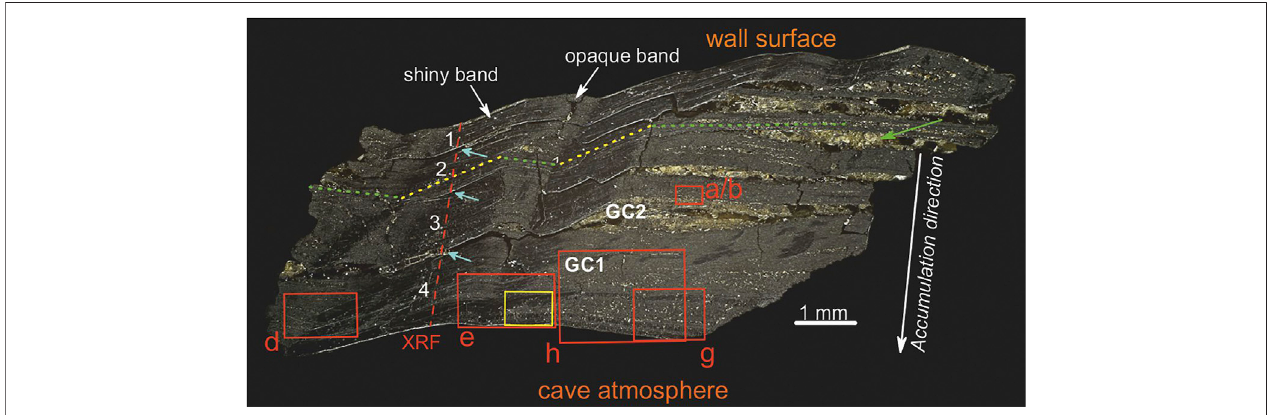
FIGURE 2 | Optical microscope image of the polished cross-section (sample GC). Red boxes indicate the areas investigated by SEM-EDS ( Figure 4 ), while the yellow box indicates the position of Raman map ( Figure 7 ). Red dashed line indicates the μ XRF scan pro fi le ( Figure 9 ). Green and yellow dotted lines show the layer orientations (horizontal and transversal, respectively). Cyan arrows indicate discontinuous surfaces between the black layers (numbered in white). The green arrow indicates a detrital lens. GC1 and GC2 show the areas selected to extract the material for XRPD and